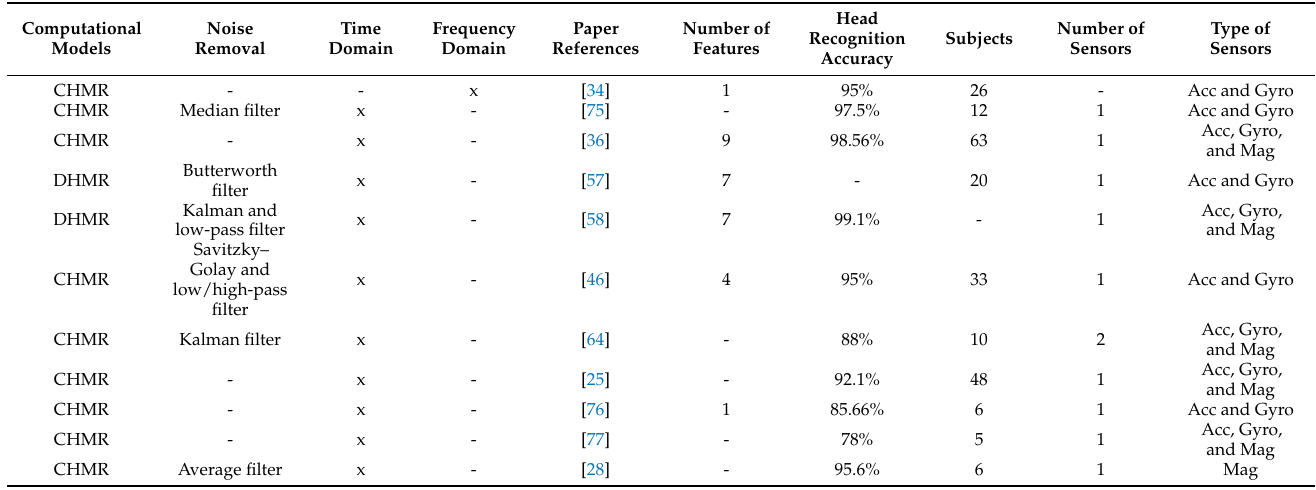
Table 2. Preprocessing and feature extraction for HMR systems. “x” means that analyses are applicable to the specified domain. For the case of “-”, this means that is not applicable to that specific domain. Computational